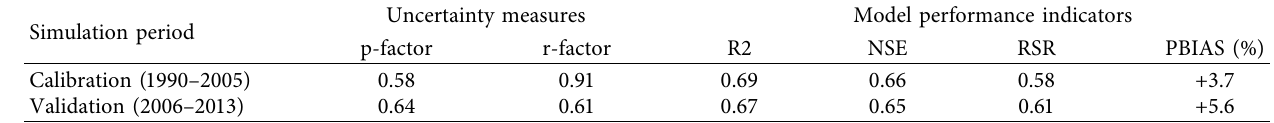
Table 10: General sediment calibration and validation